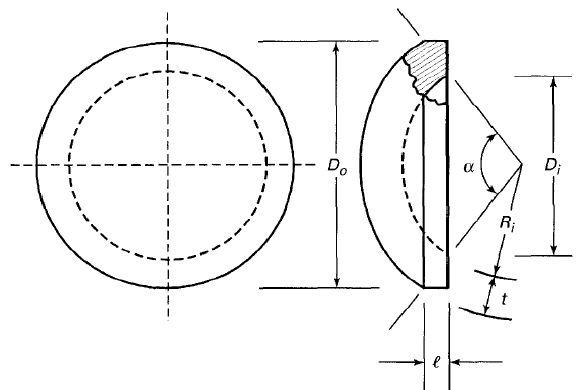
Figure 9. Viewport window of the acrylic with square edges [50]. Table 4. Properties of